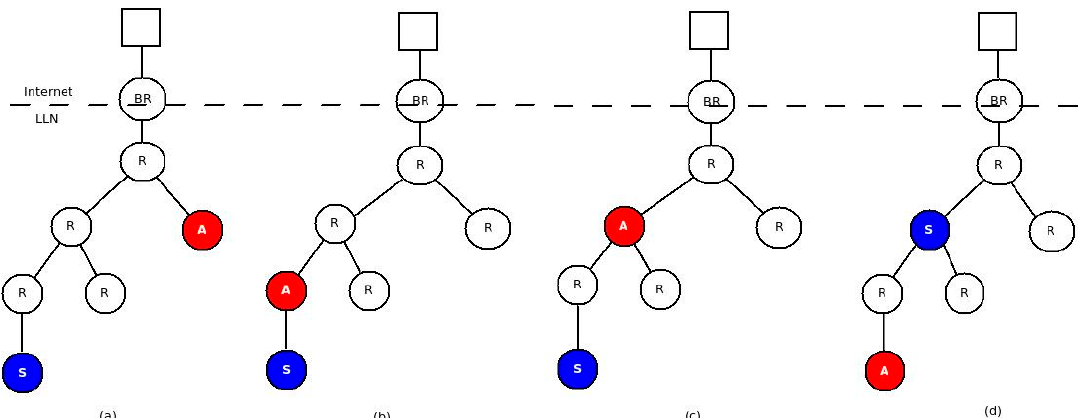
Figure 15. Topologies: ( a ) Sensor and actuator in different branch of the tree; ( b ) Actuator between Sensor and Gateway—directly connected; ( c ) Actuator between Sensor and Gateway after 1 hop; ( d ) Sensor between Actuator and Gateway after 1 hop.